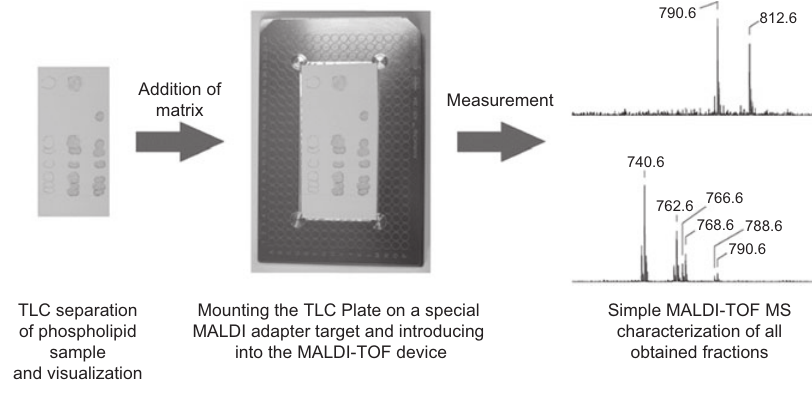
Figure 6 The general scheme for coupling TLC with MALDI. TLC/MALDI coupling was performed in the following way: PLs were sepa- rated by TLC in the conventional way and stained with the dye primuline that bound noncovalently to the acyl residues of PLs. Then, the spots of interest were soaked with matrix and the TLC plate mounted onto a special adapter target. This target was introduced into the mass spec- trometer and analyzed in the conventional manner. Reprinted from Anal. Bioanal. Chem., 389, Fuchs B., et al., “ A direct and simple method of coupling matrix-assisted laser desorption and ionization time-of-fl ight mass spectrometry (MALDI-TOF MS) to thin-layer chromatography (TLC) for the analysis of phospholipids from egg yolk ” , 827 – 834, 2007 with permission from Springer (License number